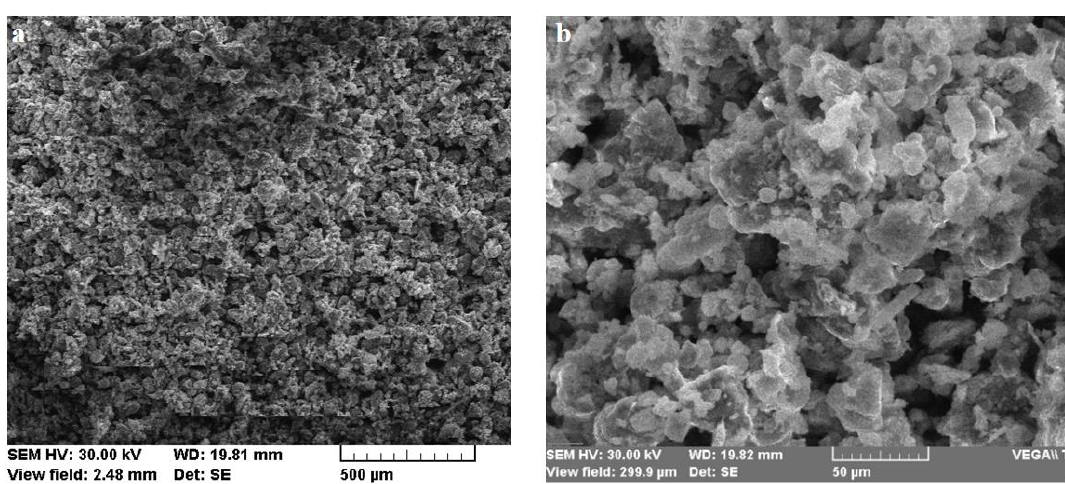
Figure 1. Scanning Electron Microscope (SEM) micrographs of indigenous fly ash after sifting: ( a ) 100X magnification; ( b ) 750X magnification.